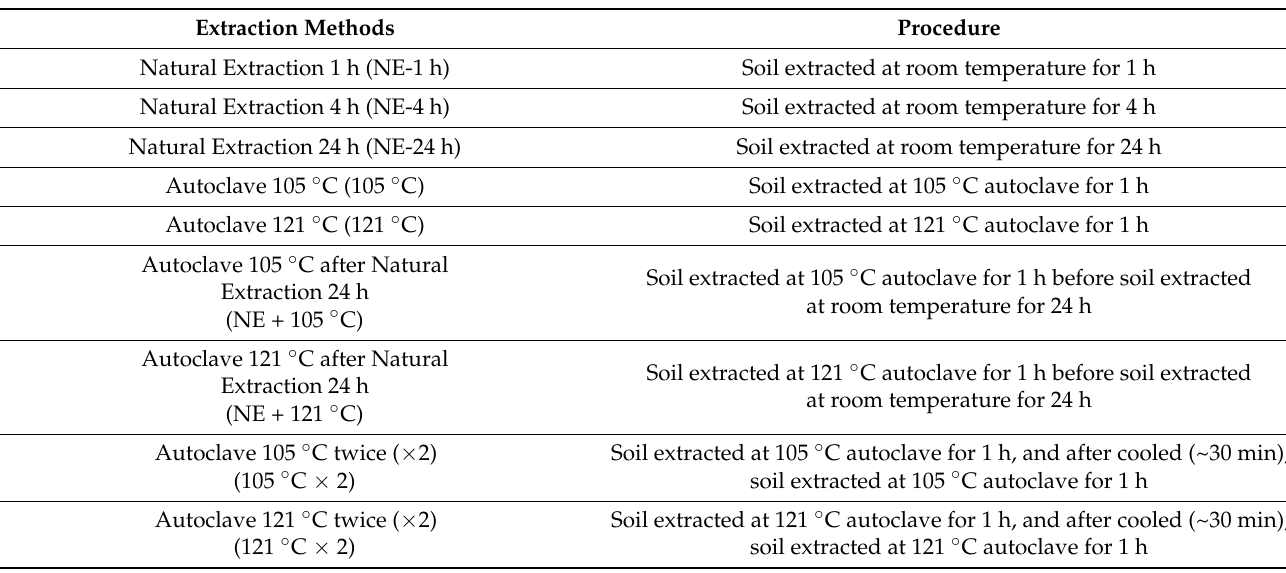
Table 5. Soil extraction methods used in this